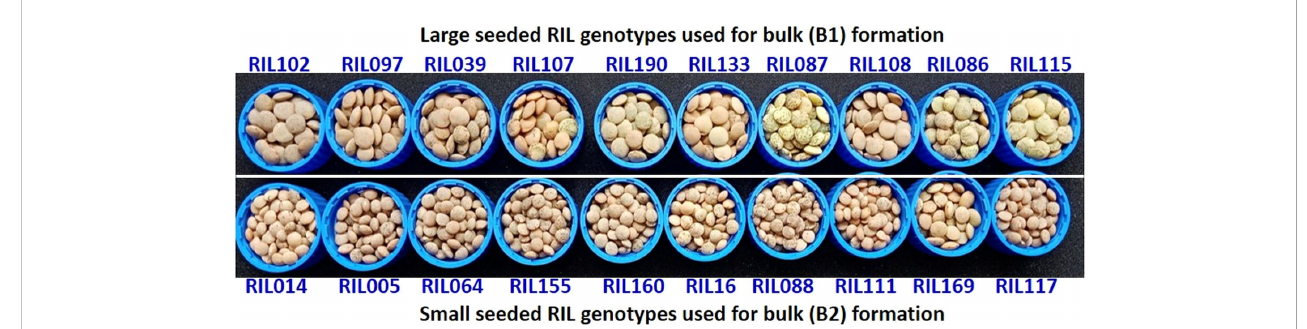
FIGURE 3 The 10 extreme RIL genotypes for seed size which was used for the formation of two extreme bulks for the BSA. Where, upper panel represents 10 RILs with maximum seed size (in descending order of their seed weight) and lower panel represents 10 RILs with minimum seed size (in ascending order of their seed